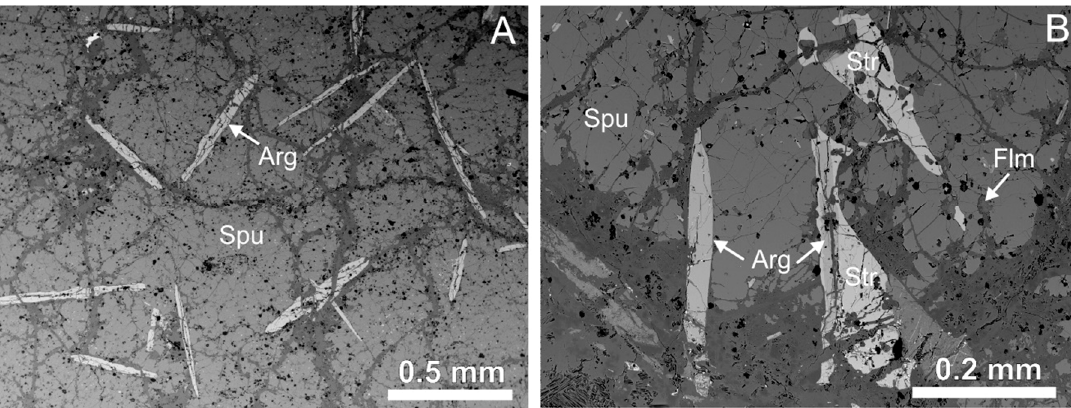
Figure 1. Disc-shaped, flattened ariegilatite crystals in spurrite rock ( A ), holotype specimen L15; overgrowing and replacing of ariegilatite by stracherite ( B ). Arg = ariegilatite, Flm = fluormayenite, Spu = spurrite, Str = stracherite.